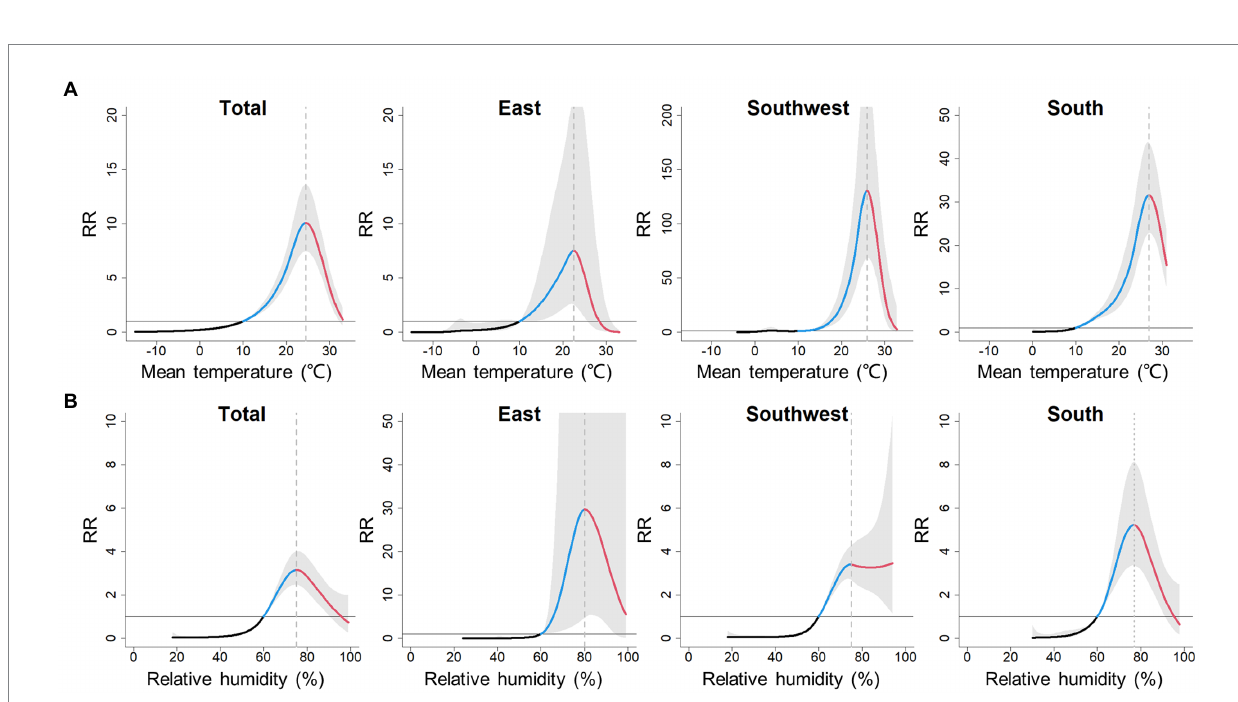
FIGURE 3 Pooled cumulative exposure-response curves for associations between weekly (A) mean temperature and (B) relative humidity, with scrub typhus incidence over 0–15 lag weeks at total and regional levels. Black, blue and red solid lines denote the meta-pooled estimates, indicating the initinal phase, elevated phase and descendent phase, respectively; shaded areas denote the 95% confidence intervals; the reference value for mean temperature and ralative humidity are 10 ° C and 60%,